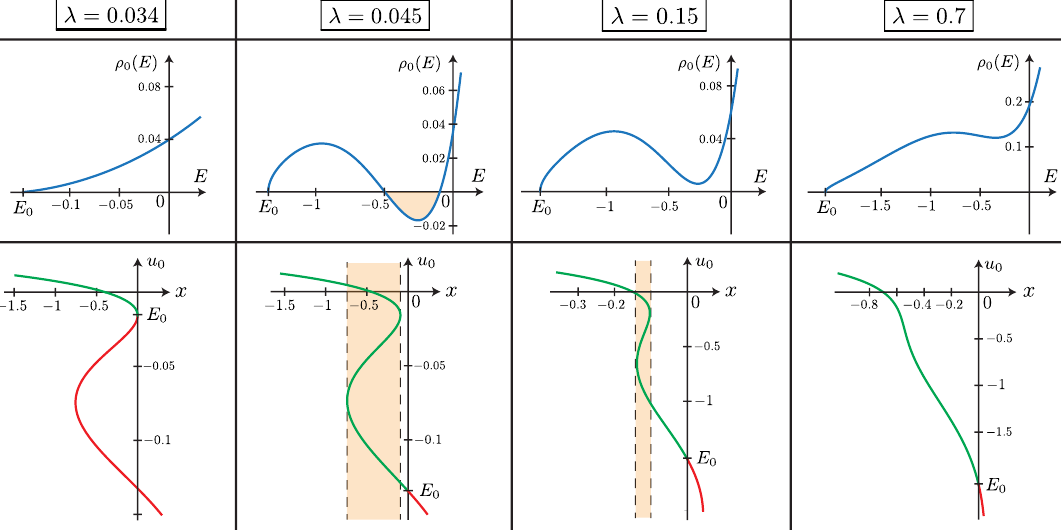
Figure 9. The first row corresponds to the ρ 0 ( E ) numerically computed from (1.9) for α = 1 / 4 and several values of λ . For λ ∈ (0 . 035 , 0 . 122) the spectral density is non-positive. In the second row we plot the curve x = x ( u 0 ) in the ( x, u 0 ) plane obtained from (4.3) with α = 1 / 4 and the same values of λ . The function u 0 ( x ) is multi-valued in the shaded region in x < 0 for a (different) finite window of λ , approximately given by λ ∈ (0 . 035 , 0 . 334)